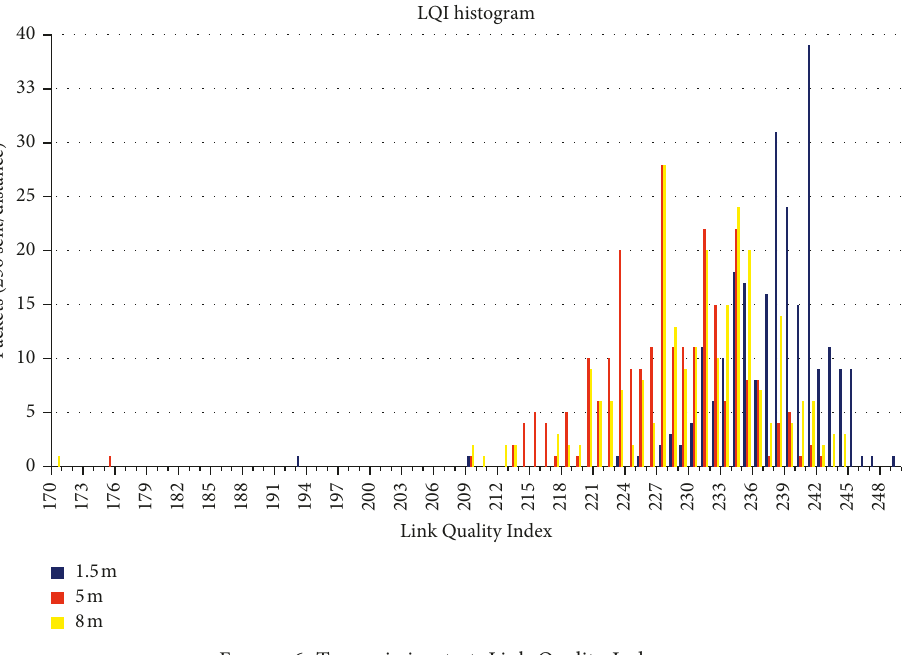
Figure 6: Transmission test: Link Quality